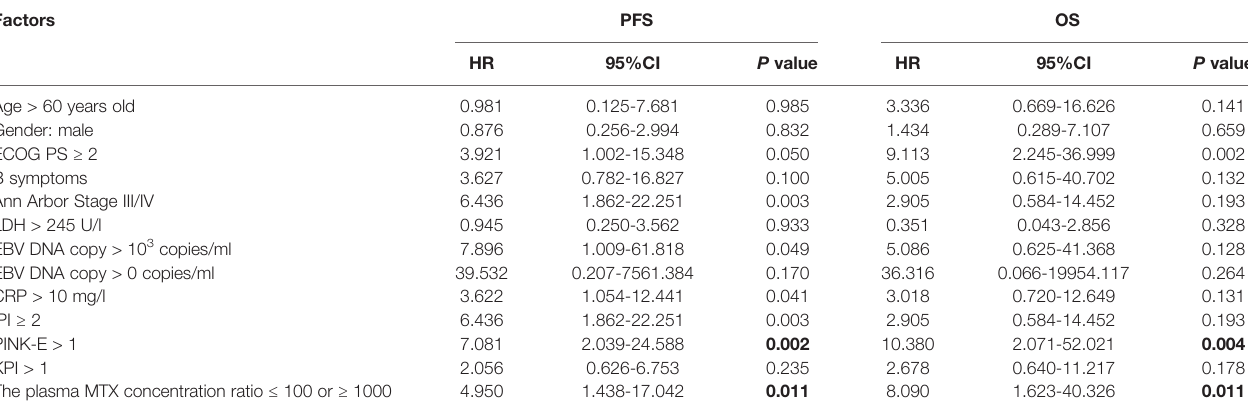
TABLE 3 | Univariate analysis of prognostic factors. Factors